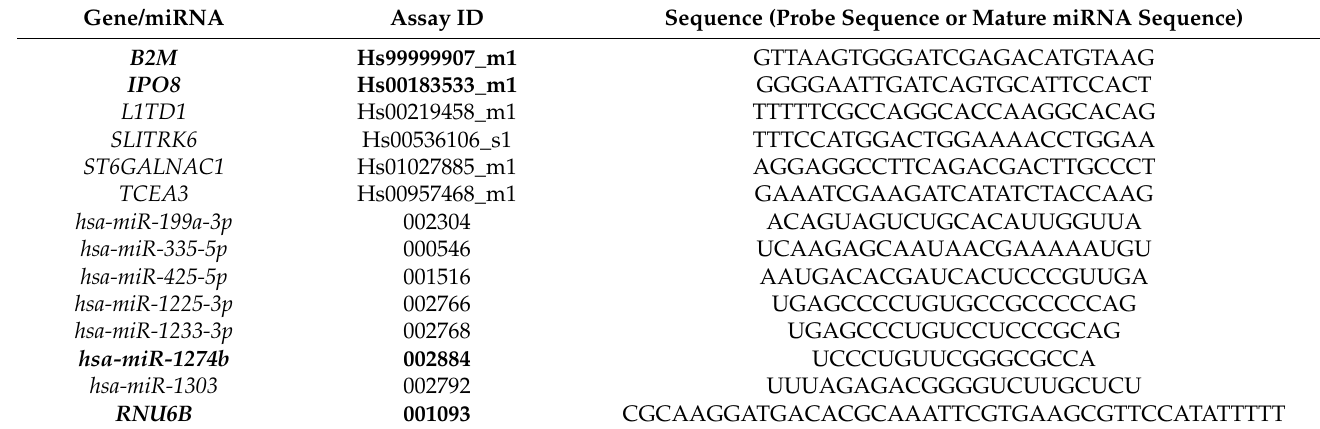
Table 1. Selected